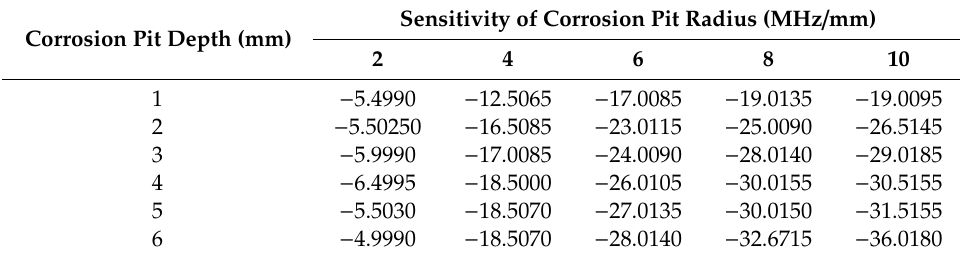
Figure 11. Influence of the volumetric corrosion pit radius on the resonant frequency. Table 4. Identification sensitivity of the corrosion pit